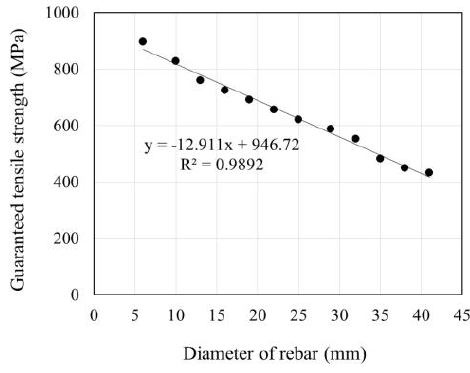
Figure 11. Change in tensile strength of GFRP rebar according to diameter [16].